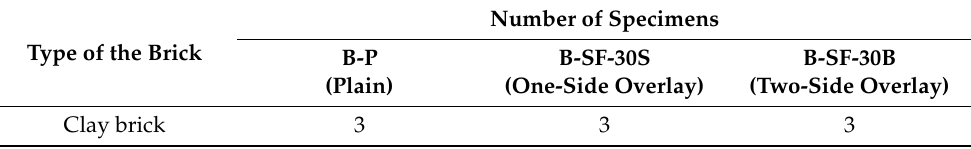
Table 2. Test program and specimen for bond strength